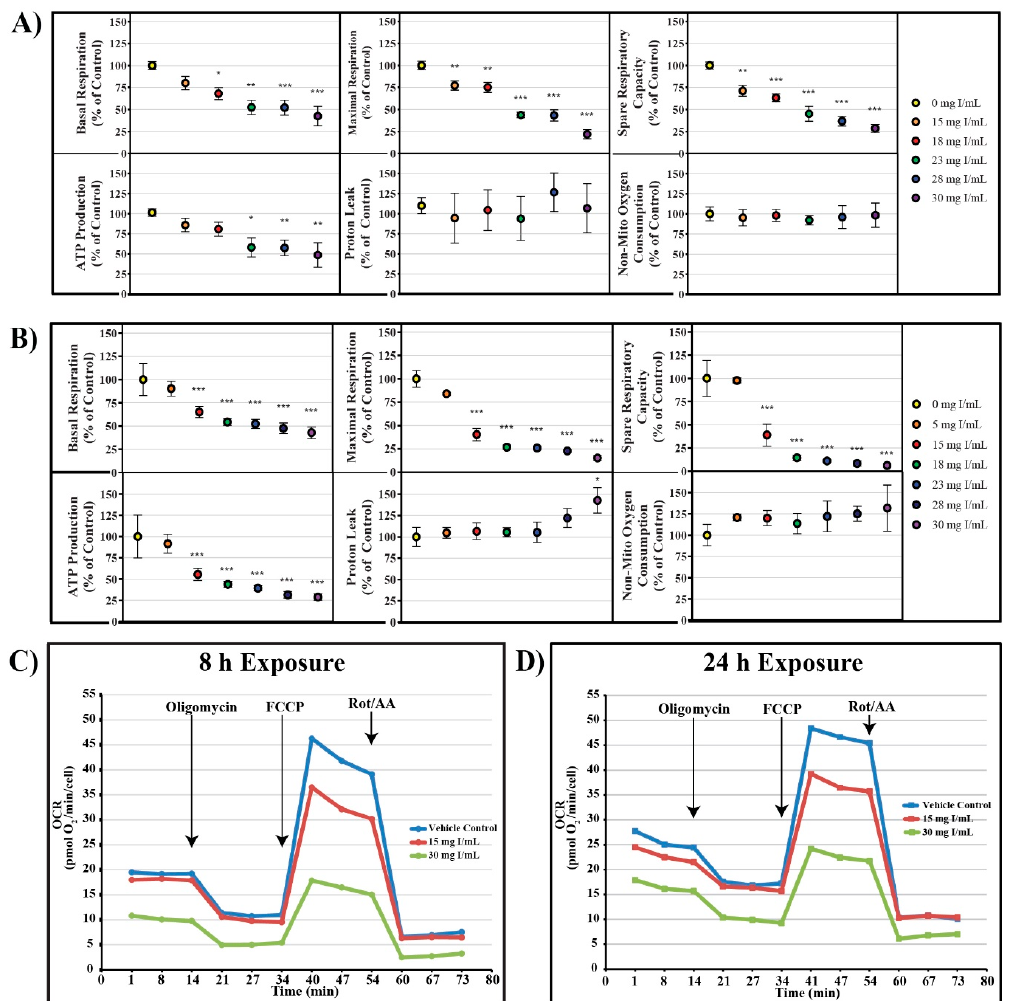
Figure 3. Diatrizoic acid effects on various parameters of mitochondrial respiration in HK-2 cells. DA diminished key parameters of mitochondrial respiration following 8 h ( A ) and 24 h ( B )